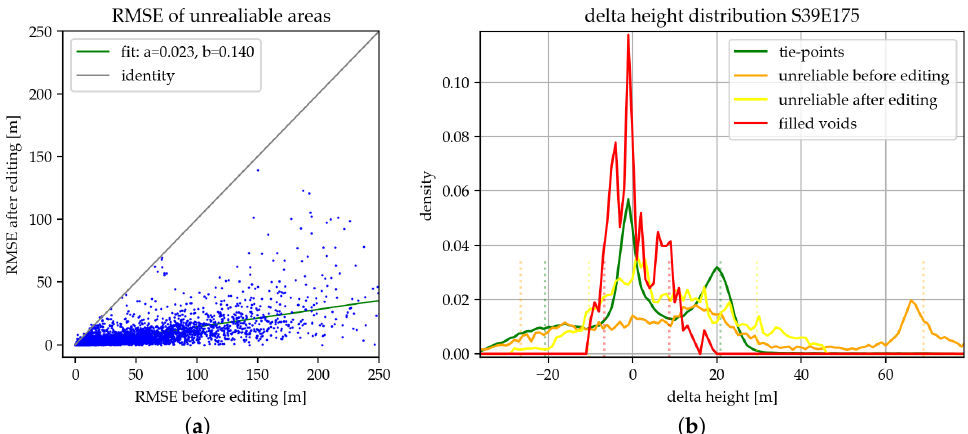
Figure 8. ( a ) RMSE quality check example over Australia: for each edition area the RMSE is calculated before editing and after editing, ( b ) normalized histogram quality check example over geocell S39E175 in New Zealand.